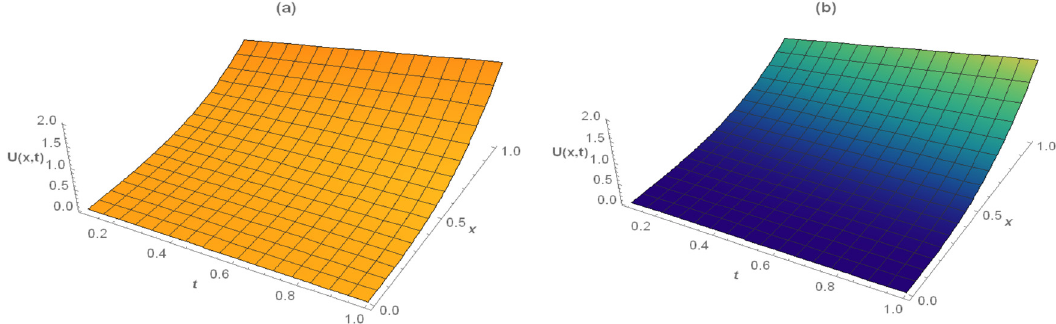
Figure 2: Graphs of approximate solutions for di ff erent time levels at ( a ) α 0.5 = part and ( b ) α 0.75 =